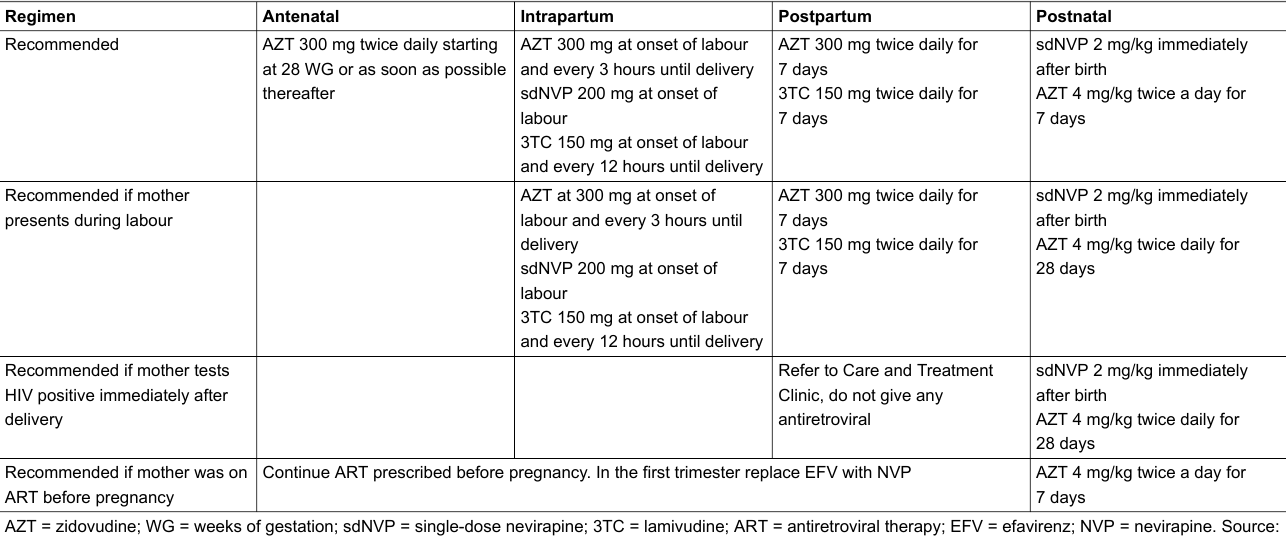
Table 2: Recommended combination antiretroviral prophylaxis regimens to prevent mother-to-child transmission of HIV according to the 2007 Tanzanian national guidelines for the Prevention of Mother-To-Child Transmission of HIV. Regimen Antenatal